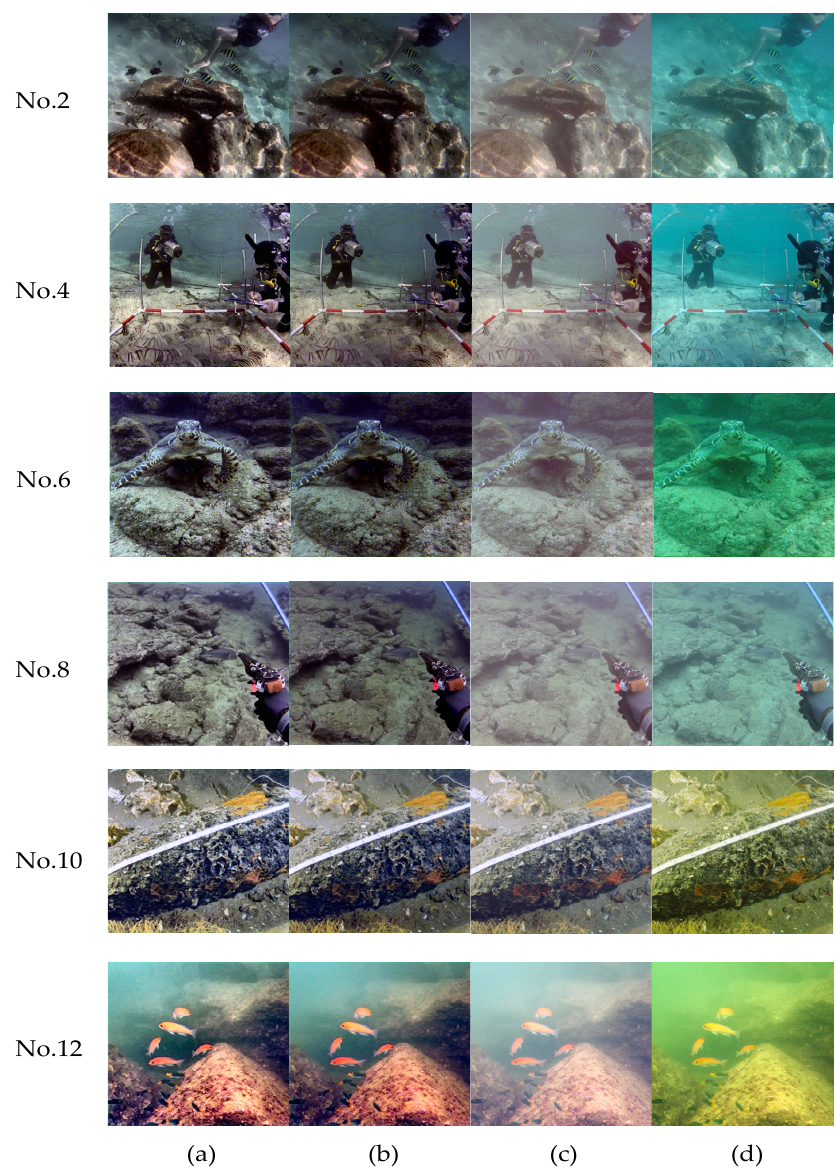
Figure 10. Results of ablation experiments, ( a ) is the result of the fusion algorithm proposed in this paper; ( b ) is the result of removing the CLAHE method and only retaining the dehazing algorithm and the color balance algorithm; ( c ) is the result after only the color balance processing; and ( d ) is the original input image.